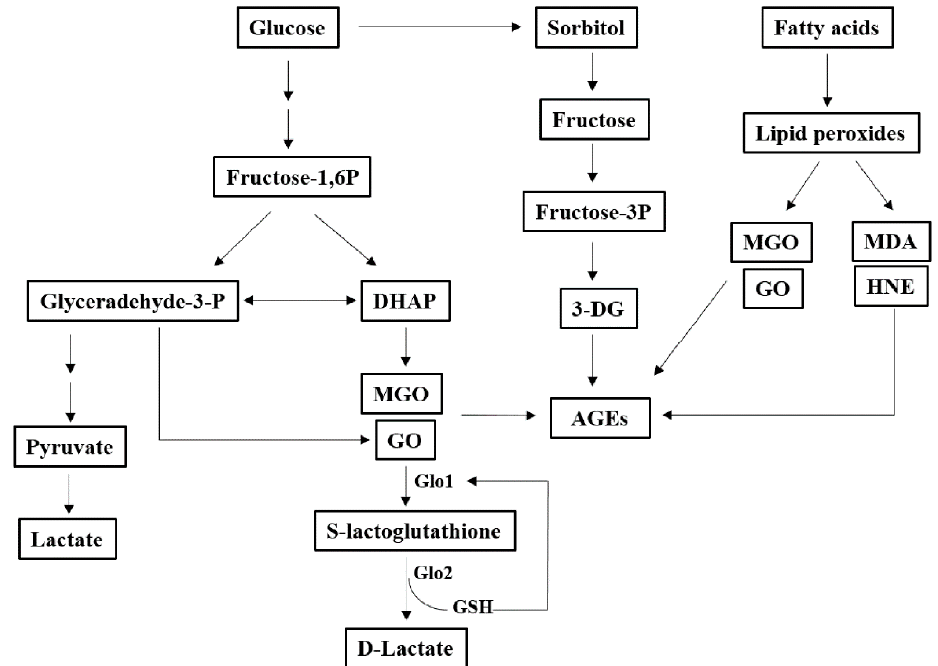
Figure 1. Formation of dicarbonyls and advanced glycation end products (AGEs) from glucose and fatty acid intermedi- ates. During glycolysis, glucose is converted into pyruvate, which subsequently forms lactate. Glycolysis intermediates, glyceraldehyde-3-phosphate, and dihydroxyacetone phosphate (DHAP) are degraded to glyoxal (GO) and MGO, respec- tively. The glyoxalase system further detoxifies MGO and GO. MGO, GO, and other dicarbonyl compounds including malondialdehyde (MDA) and 4-hydroxynonena (HNE) are formed during lipid peroxidation via degradation of lipid peroxides. Furthermore, 3-deoxyglucosone (3-DG) is formed from fructose-3-phosphate through the polyol pathway. These dicarbonyl compounds form AGEs by reacting with proteins, lipids, and nucleic acids. AGEs, advanced glycation end products; DHAP, dihydroxyacetone phosphate; MGO, methylglyoxal; GO, glyoxal; 3-DG, 3-deoxyglucosone; MDA, malondialdehyde; HNE, 4-hydroxynonena; Glo1, glyoxalase I; Glo2, glyoxalase II.